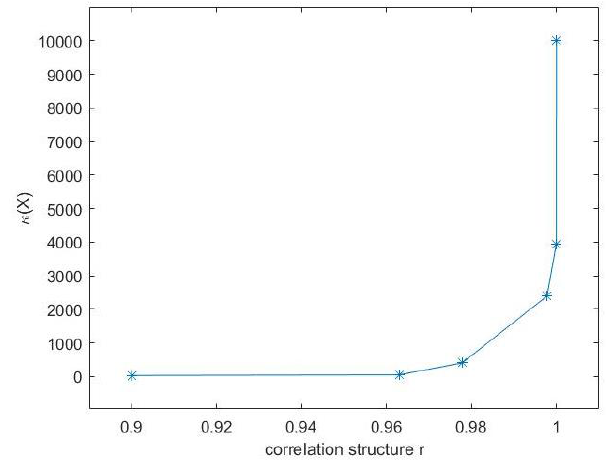
Figure 2. The generalised condition number of X as a function of the correlation r